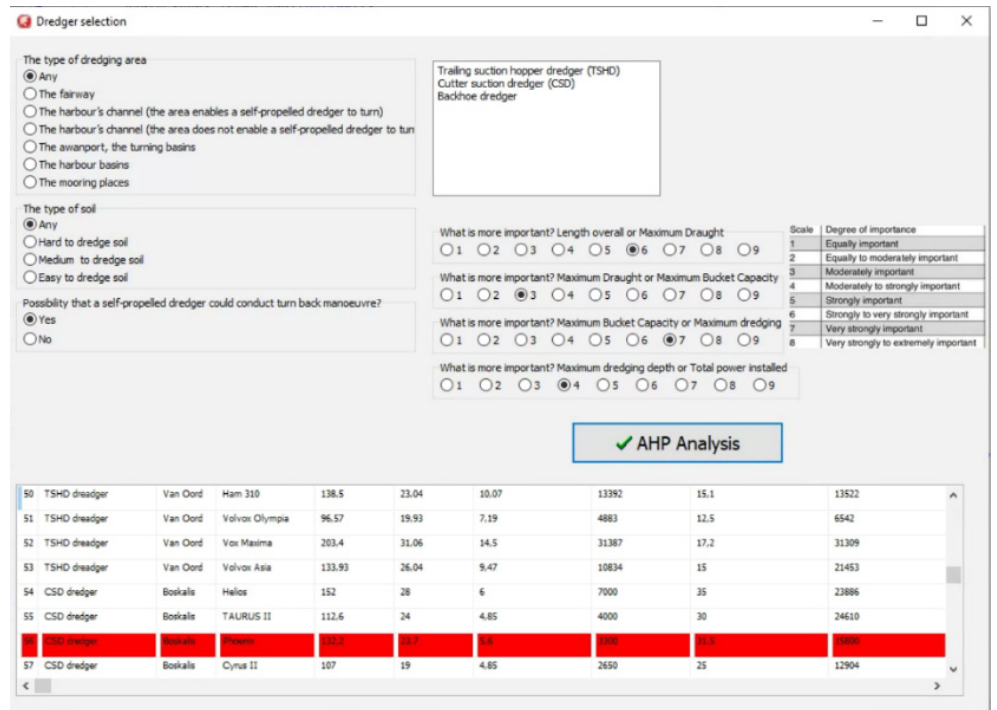
Figure 7. Dredger selection with AHP analysis.